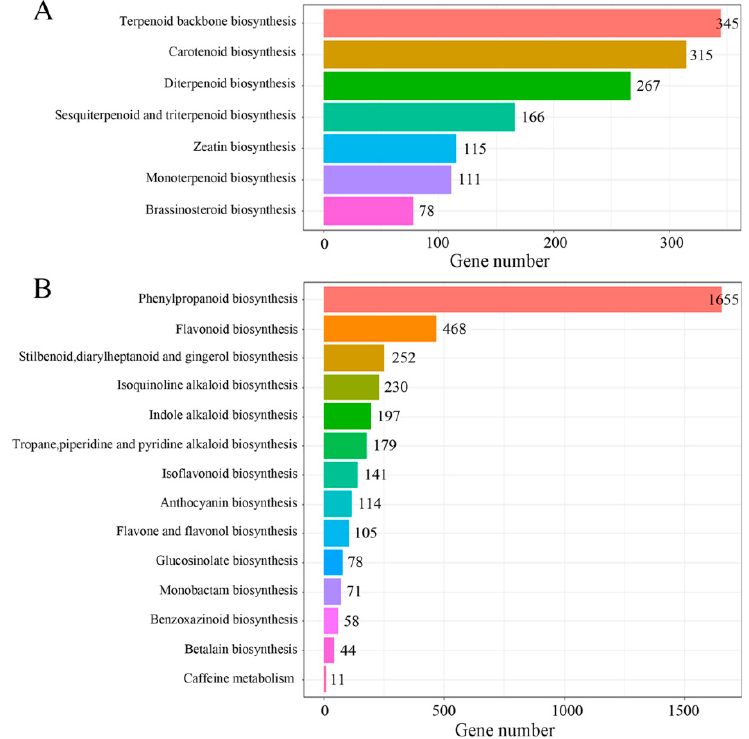
Figure 2. Kyoto Encyclopedia of Genes and Genomes (KEGG) annotation of C. chinense. ( A ) Classifications based on the metabolism of terpenoids and polyketides. ( B ) Classifications based on biosynthesis of other secondary metabolites.